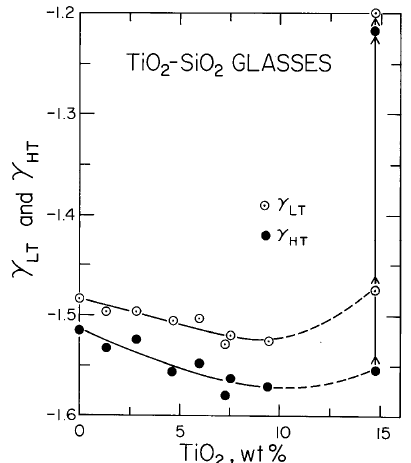
Figure 7. Variation of the low-temperature and high-temperature limits of the acoustic Grüneisen parameter as a function of the TiO 2 content.